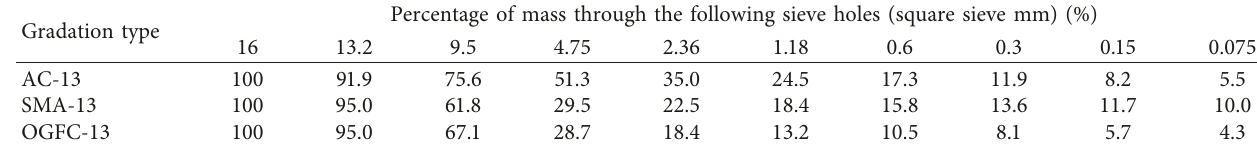
Table 5: Gradation design.